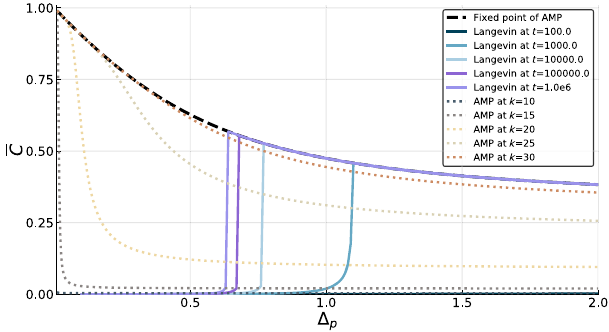
FIG. 4. Correlation with the signal of the AMP and Langevin at the k th iteration (at time t ) for fixed Δ 2 ¼ 0 . 7 , where both the evolutions start with initial overlap 10 − 4 .